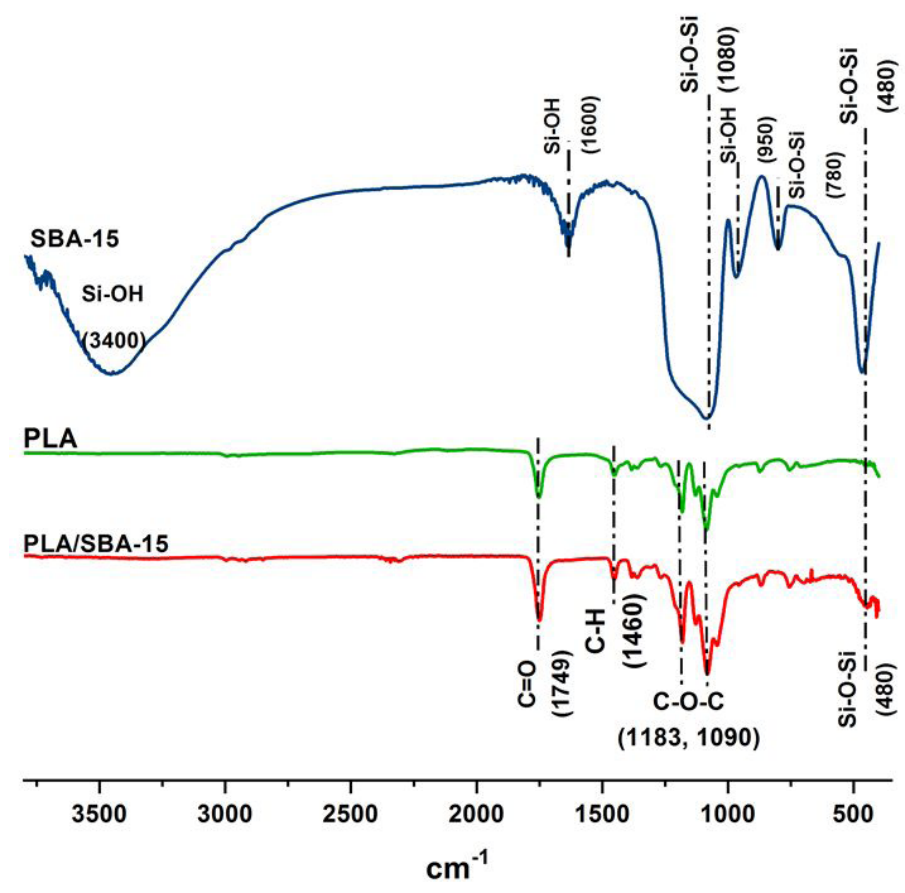
Figure 6. FTIR spectra of SBA‑15 mesoporous ceramic material (a), PLA spun membrane of 10% (b), and PLA/SBA15 composite scaffold